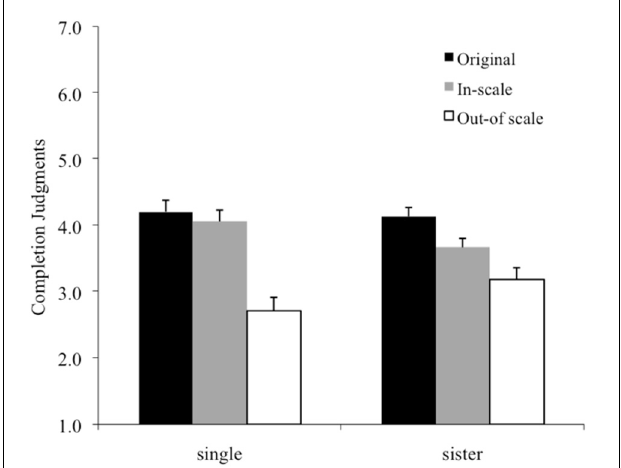
refer to standard errors of the